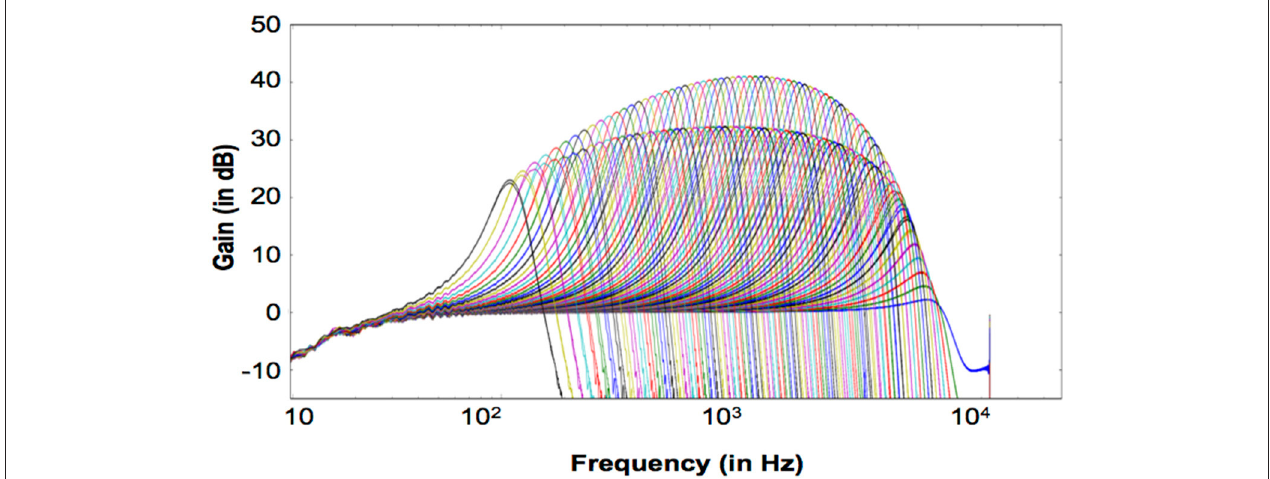
FIGURE 9 | Transfer function of the 70-channel CAR-FAC system to a -40 dB FS, 1s sine tone sweep from 20Hz to 22.05kHz (squared-cosine rise and decay time of 0.1s to minimize the influence of the spectral splatter). The CAR response (Upper) when the FAC function is switched off; The CAR-FAC response (Lower).